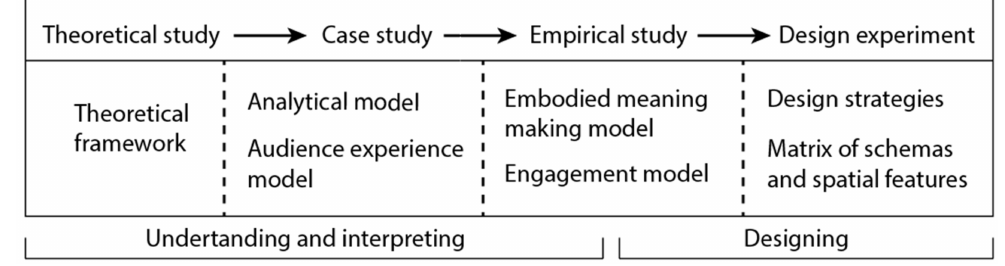
Figure 7. Evolution of